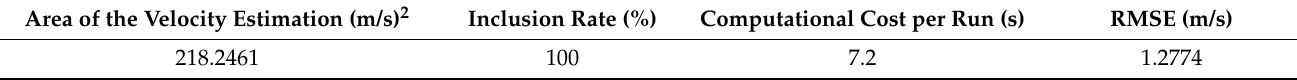
Table 1. Performance of the proposed